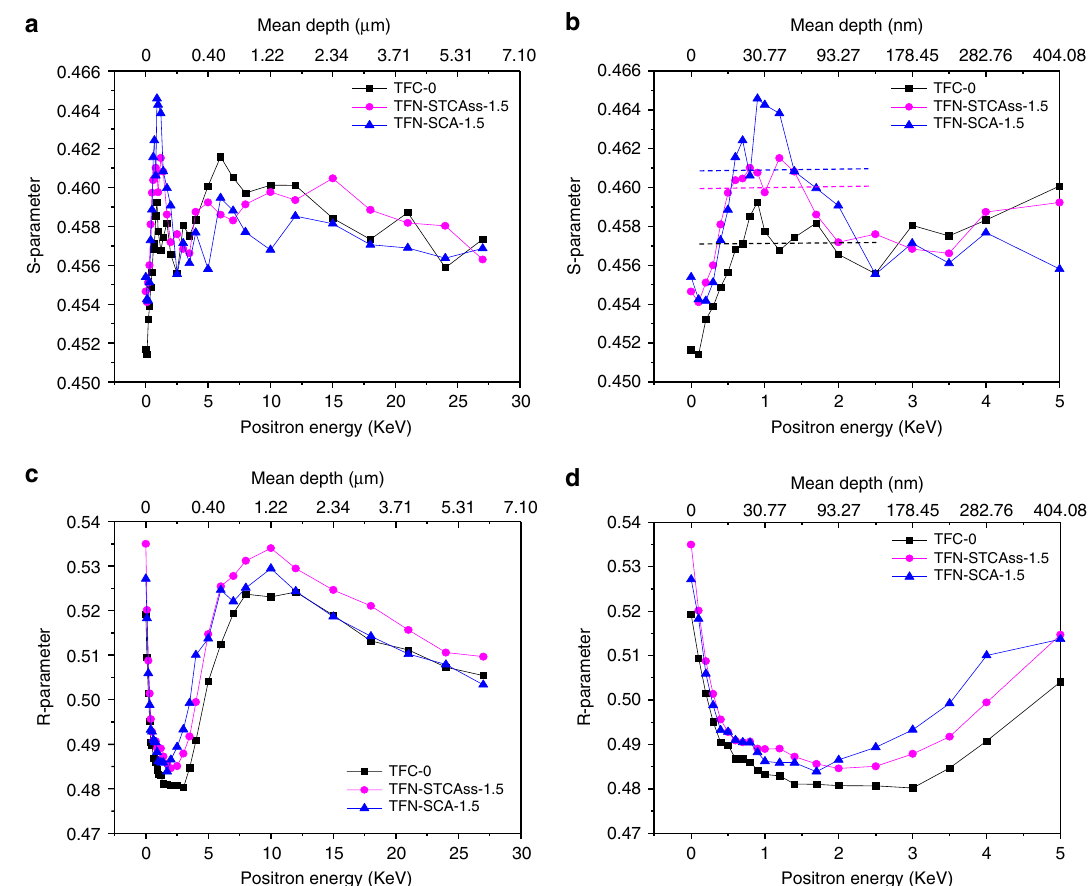
Fig. 5 Membrane microstructures. a , b S-parameters and c , d R-parameters of TFC-0, TFN-STCAss-1.5, and TFN-SCA-1.5. The dotted lines in b indicate the average values of S-parameters of polyamide networks for guiding the